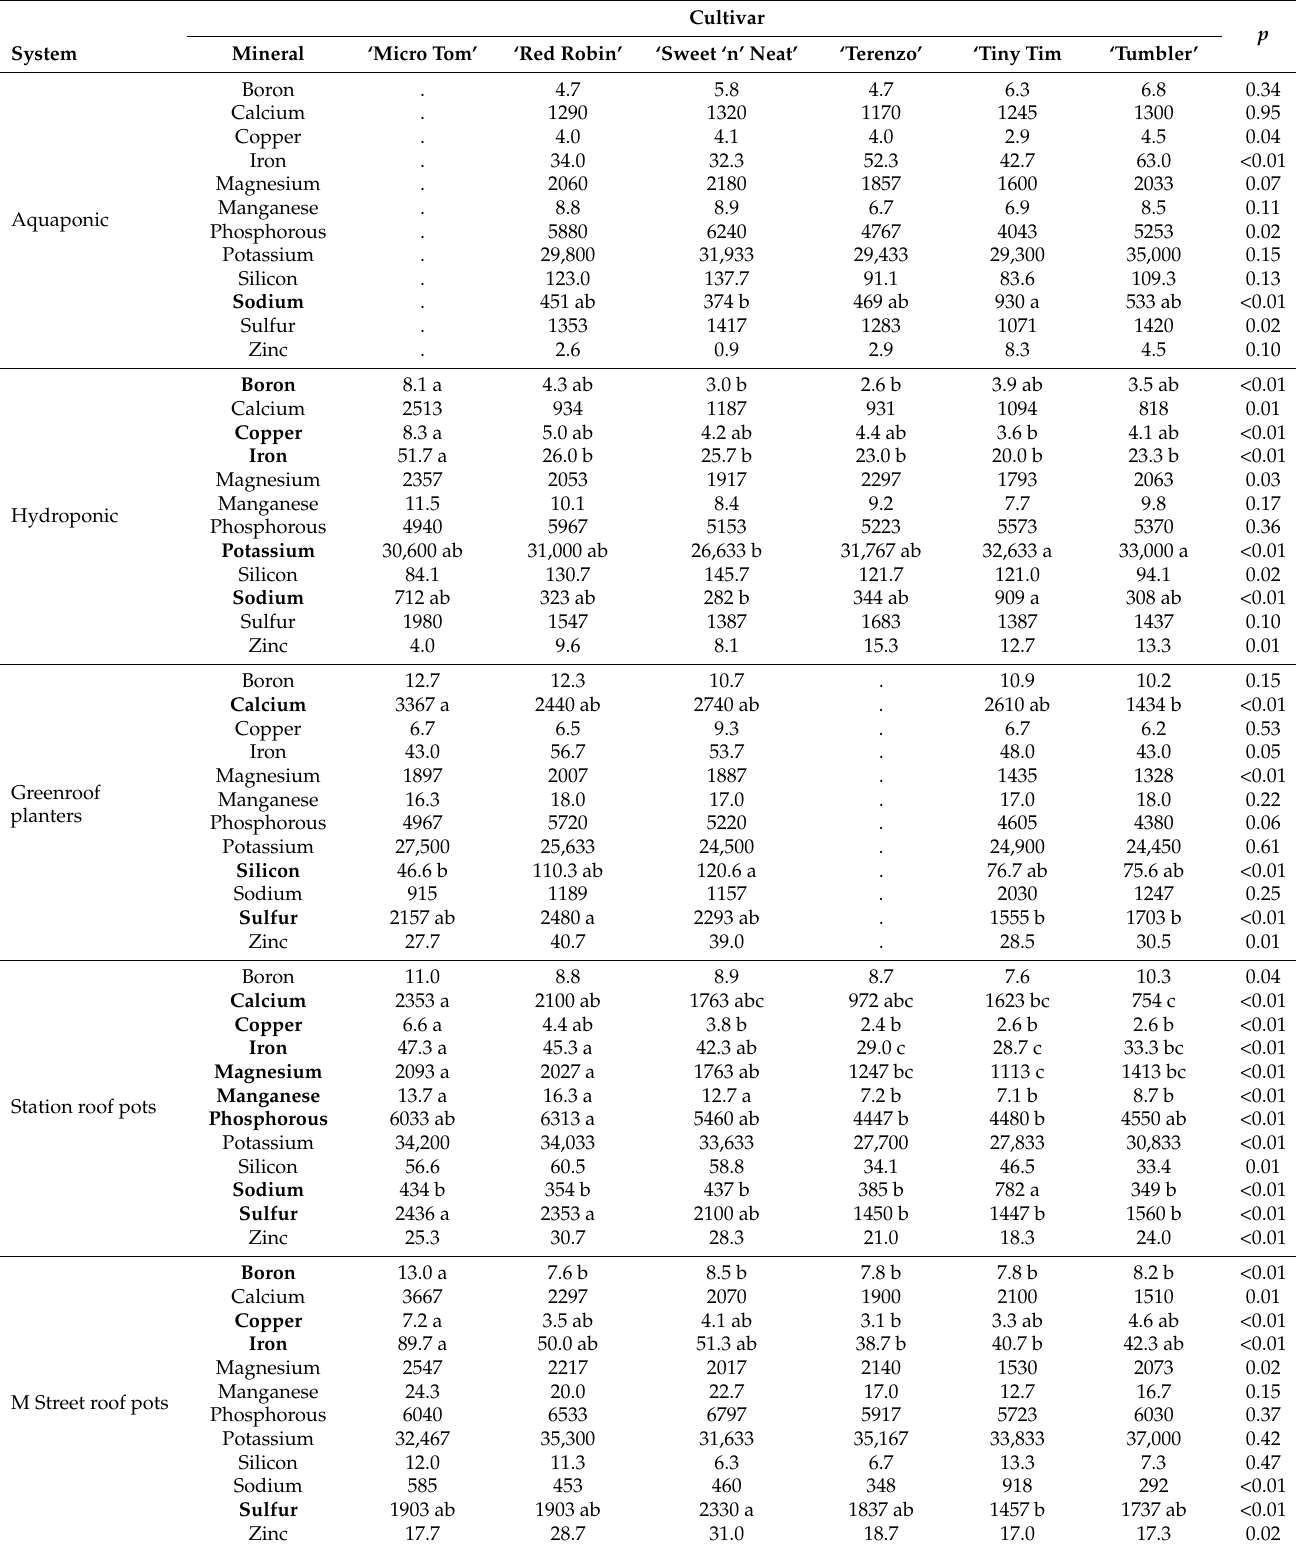
Table 3. Mean mg/kg of minerals that differed in cherry tomatoes across six cultivars in five systems. Means with different letters within a row are different (Tukey–Kramer means separation test, p < 0.05). Cultivar p System Mineral ‘Micro Tom’ ‘Red Robin’ ‘Sweet ‘n’ Neat’ ‘Terenzo’ ‘Tiny